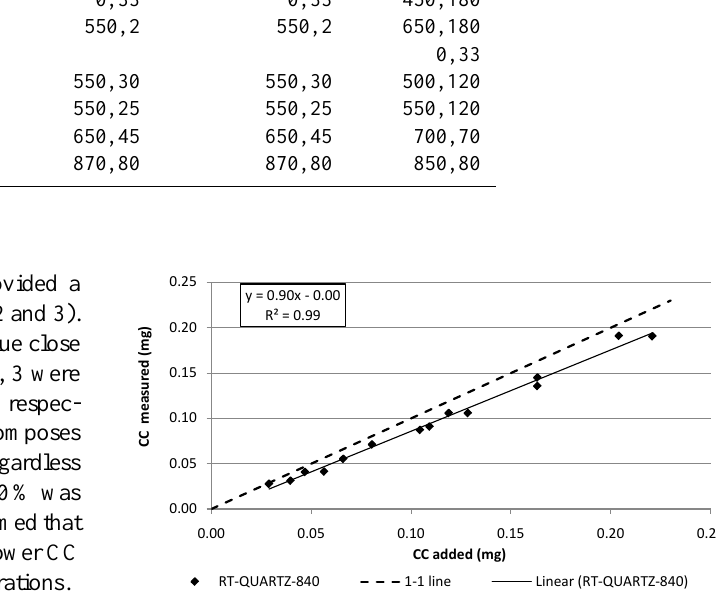
Fig. 1. Regression between CC quantities measured by the RT- QUARTZ-840 thermal protocol and CC quantities initially added on filter blanks.